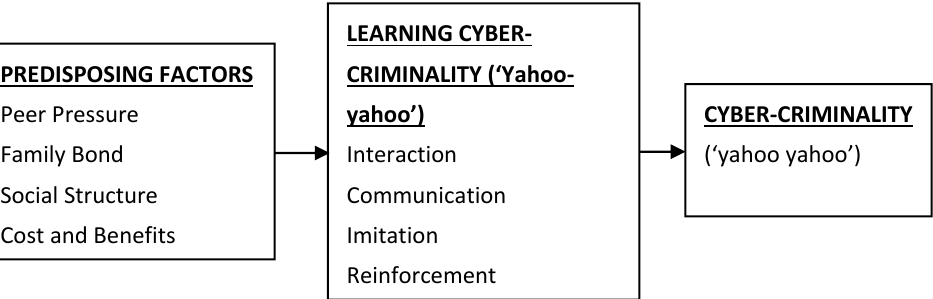
Figure 1. Relationships between predisposing factors and cyber-crime in Nigeria.